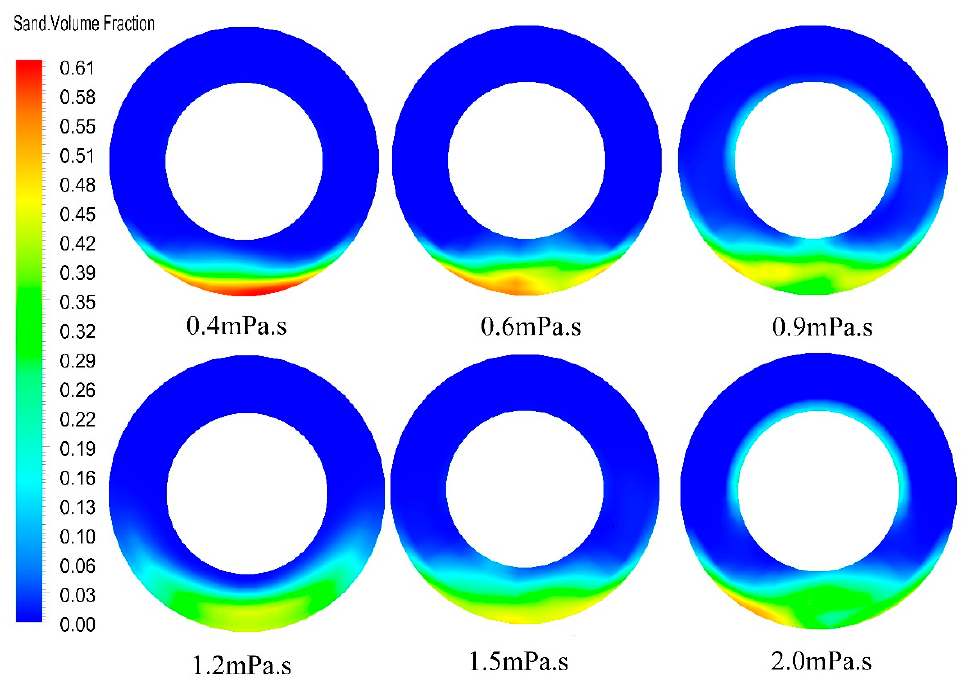
Figure 13. The contour of the effect of carrying-fluid viscosity on the volume fraction.